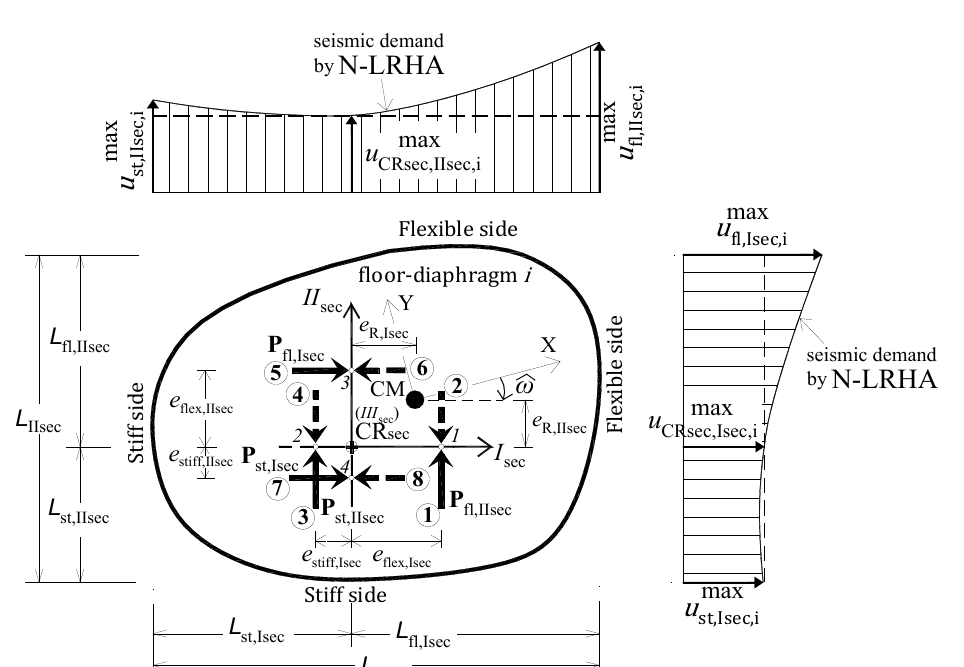
Figure 2. Application of the lateral static loads on each i -floor at two different positions determined by the inelastic dynamic eccentricities e flex and e stiff along each horizontal principal direction. Positions 3, 1 and 4, 2 are used, respectively, to safely estimate the ductility demands at the flexible and stiff sides of the multi-story building along the I sec and II sec axes, when the accidental eccentricity is not considered in analysis.